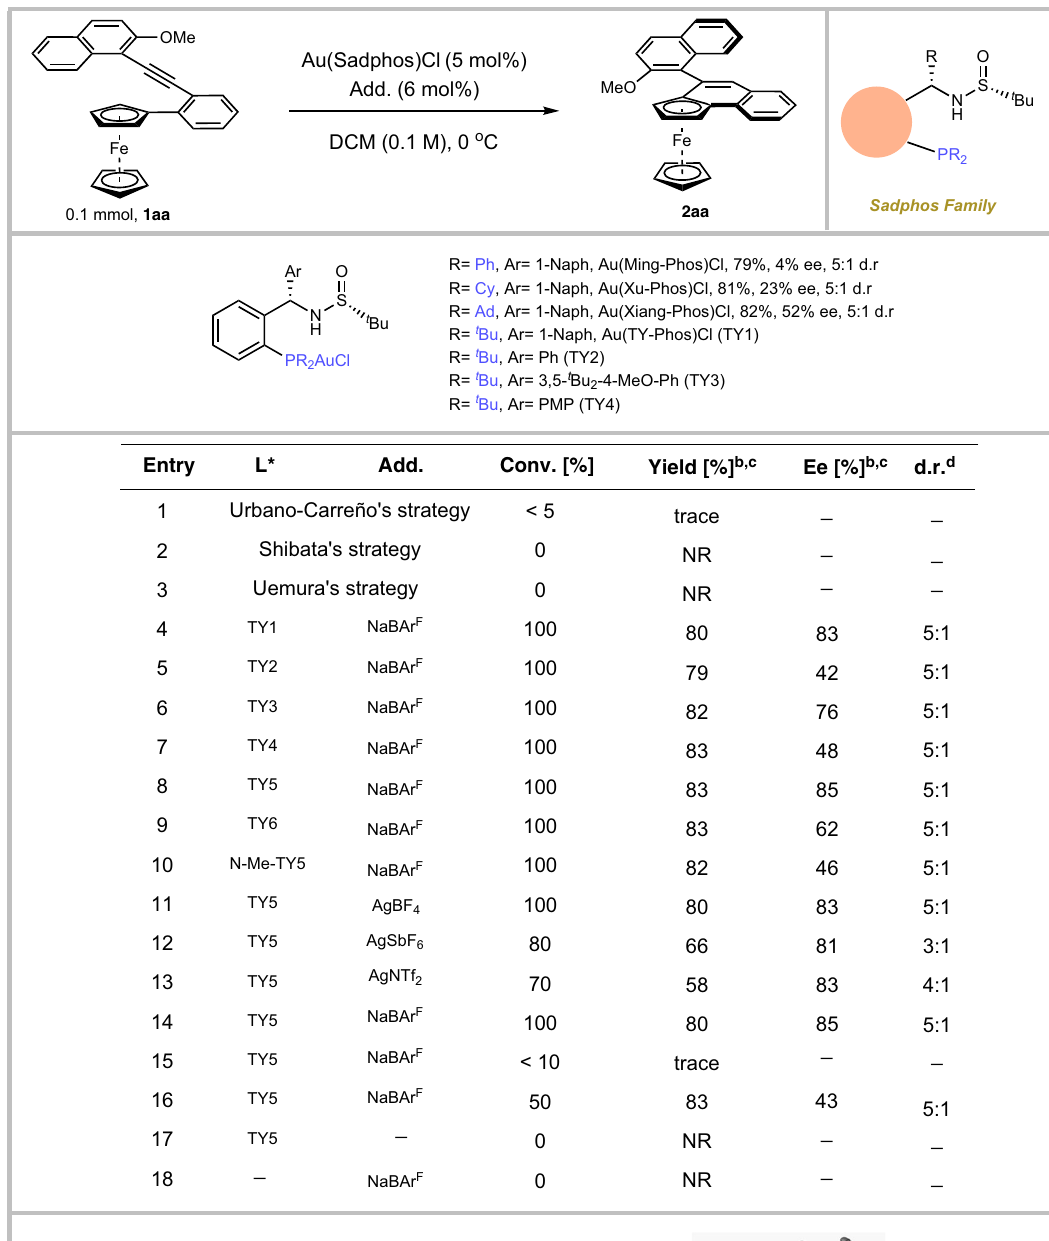
Fig. 2 Optimization of reaction conditions. a Unless otherwise noted, all reactions were carried out with 0.1 mmol of 1aa and 10 mol% of catalyst (Au: P: NaBAr F (additive) = 1:1:1.2) in 1.0 mL DCM at 0 °C for 24 h; b Isolated yield. c Determined by chiral HPLC. d Determined by NMR. e At − 10 °C; f In 1.0 mL toluene; g In 1.0 mL DCE. Shibata ’ s strategy: PtCl 2 (cod) (10 mol%), ( S,S )-Ph-BPE (10 mol%) and AgBF 4 (20 mol%) in DCE at r.t.; Urbano-Carreño ’ s strategy: ( R )-DTBM-SEGPhos(AuCl) 2 (10 mol%) and AgSbF 6 (20 mol%) in toluene at 0 °C; Uemura ’ s strategy: [Pd(MeCN) 4 ](BF 4 ) 2 (5 mol%) and ( R )- Binap (10 mol%) in DCE at 60 °C.